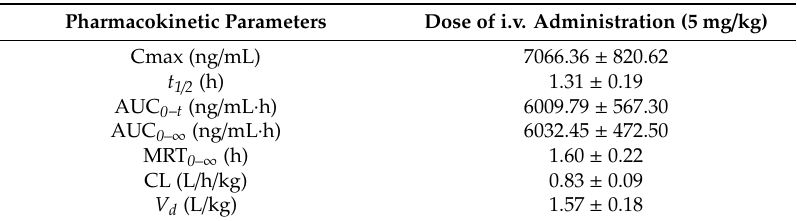
Table 5. Non-compartmental plasma pharmacokinetic parameters following a single intravenous administration of alnustone (5 mg / kg) to rats ( n =